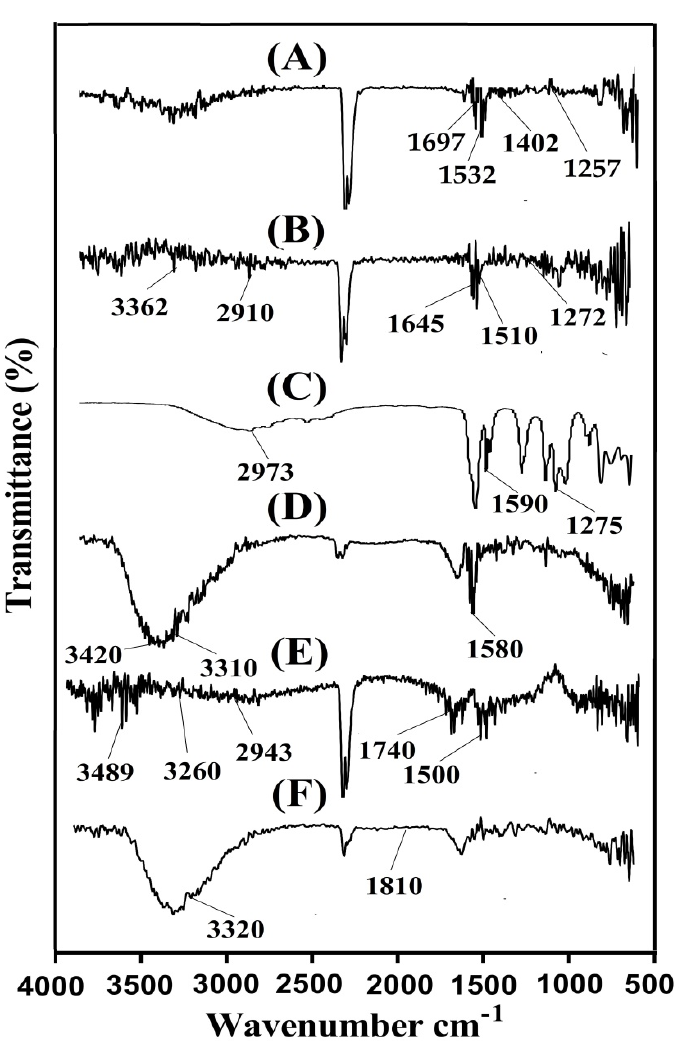
Figure 3. FTIR spectra of ( A ) Aspartic acid (ASP), ( B ) Alginate (AL), ( C ) Acrylic acid (AA), ( D ) un- loaded ASP/ALPAA hydrogels, ( E ) Ibuprofen (IBP), and ( F ) drug-loaded ASP/ALPAA hydrogels.